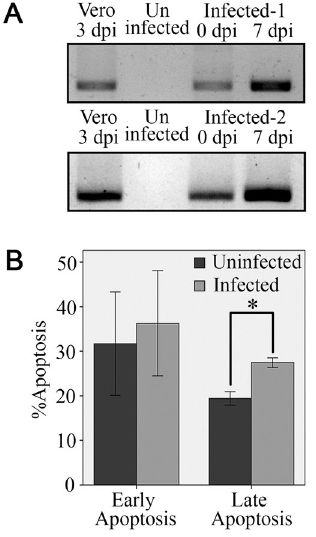
Figure 5. Dengue virus replicates itself in CD42b + cells and eventually kills those cells. MEG-01 cells were infected with DENV (MOI = 0.5) for 2 hours and washed with PBS. The cultures were maintained in fresh medium before performing RT-PCR and apoptosis assays. ( A ) RT-PCR of the culture medium of DENV- infected Vero cells, the culture media of uninfected and DENV-infected MEG-01 cells. dpi = days post infection. Infected-1 and -2 experiments were 2 independent experiments. ( B ) Apoptosis assays of uninfected and DENV-infected MEG-01 cells at 7 dpi. Early apoptosis means Annexin V + PI − cells and late apoptosis means Annexin V + PI + cells. Data are presented as mean ± SEM of four independent experiments. The Mann- Whitney U test was used to assess the significance of differences between the observed data. * p <